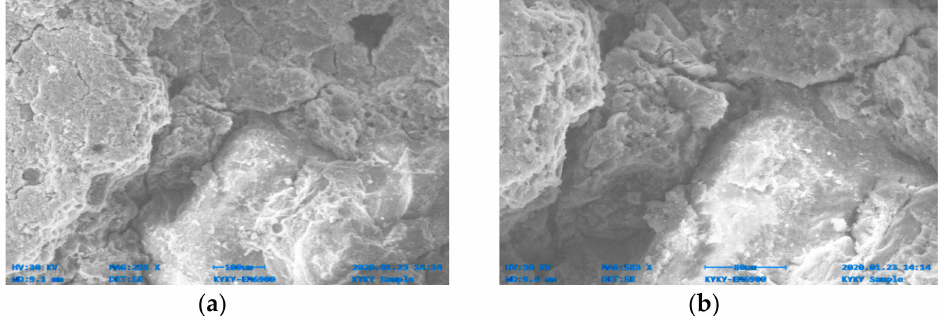
Figure 18. SEM image of GPC-E0F mix specimen; ( a ) magnification 293 × ; and ( b ) magnification 583 × .